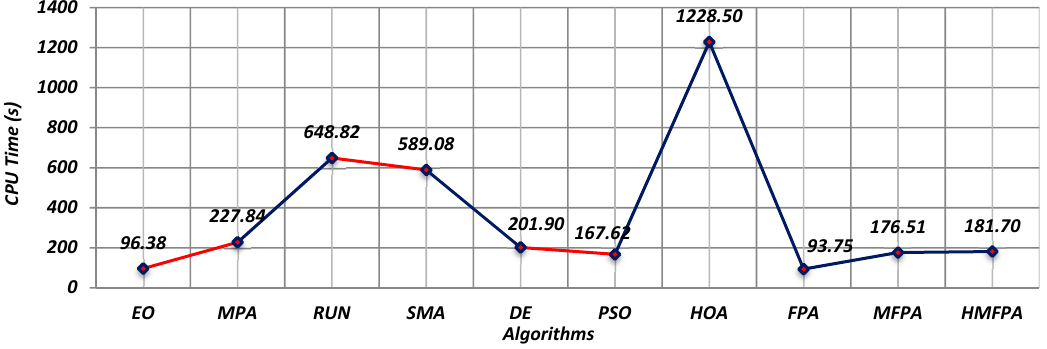
Figure 8. Comparison in term of CPU time on global optimization problems.